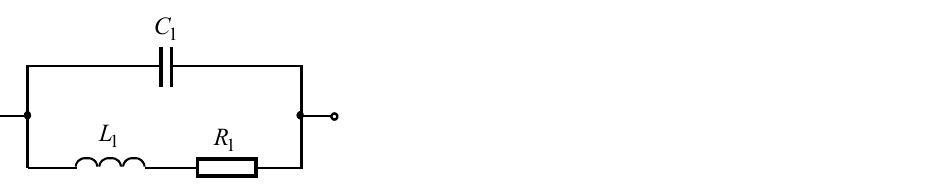
Figure 10. Equivalent circuit model of the flexible substrate based samples with composite piezoelectric films.